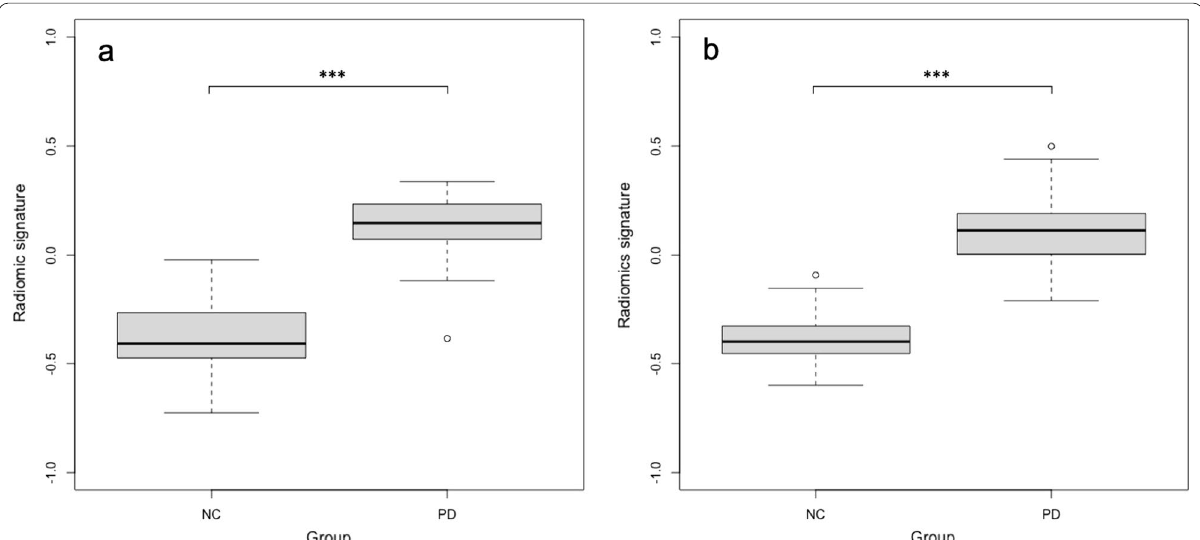
Fig. 5 Comparison of radiomics signature between the normal control and Parkinson’s disease. Box-and-whisker plots indicate the radiomics signature distribution. a Test dataset 1, b test dataset 2. *** P < 0.001